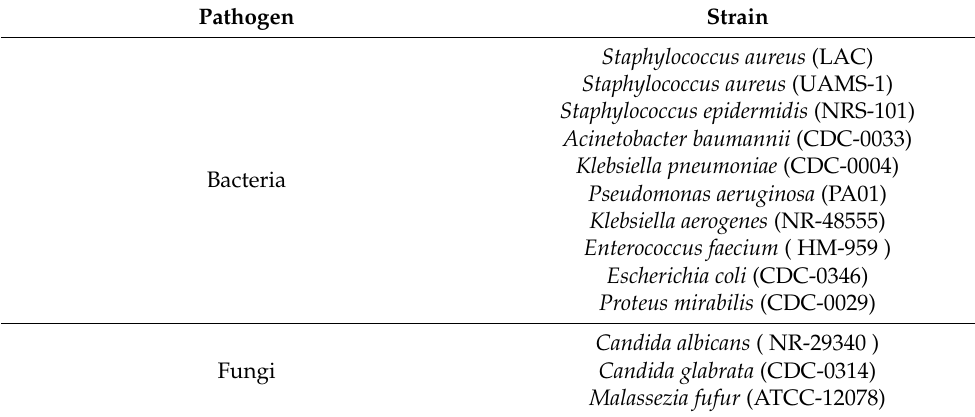
Table 2. This table lists the specific bacteria and fungus species evaluated using SPME-DART-MS in this